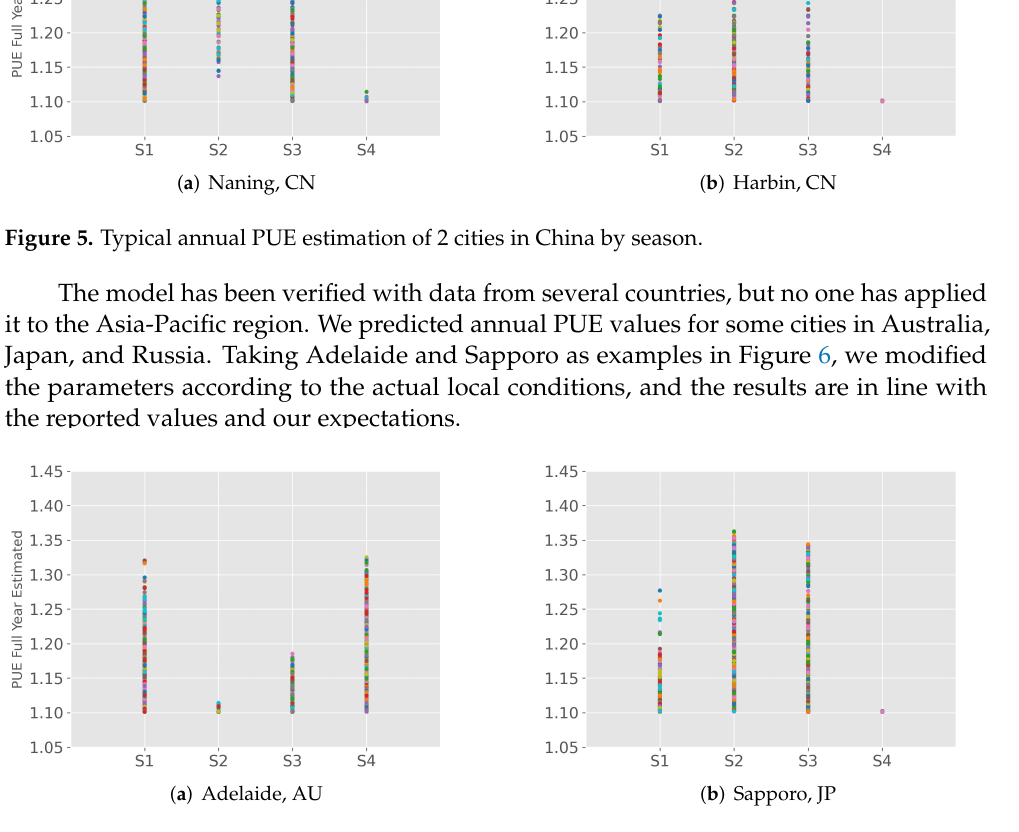
Figure 6. Typical annual PUE estimation of 2 cities worldwide by